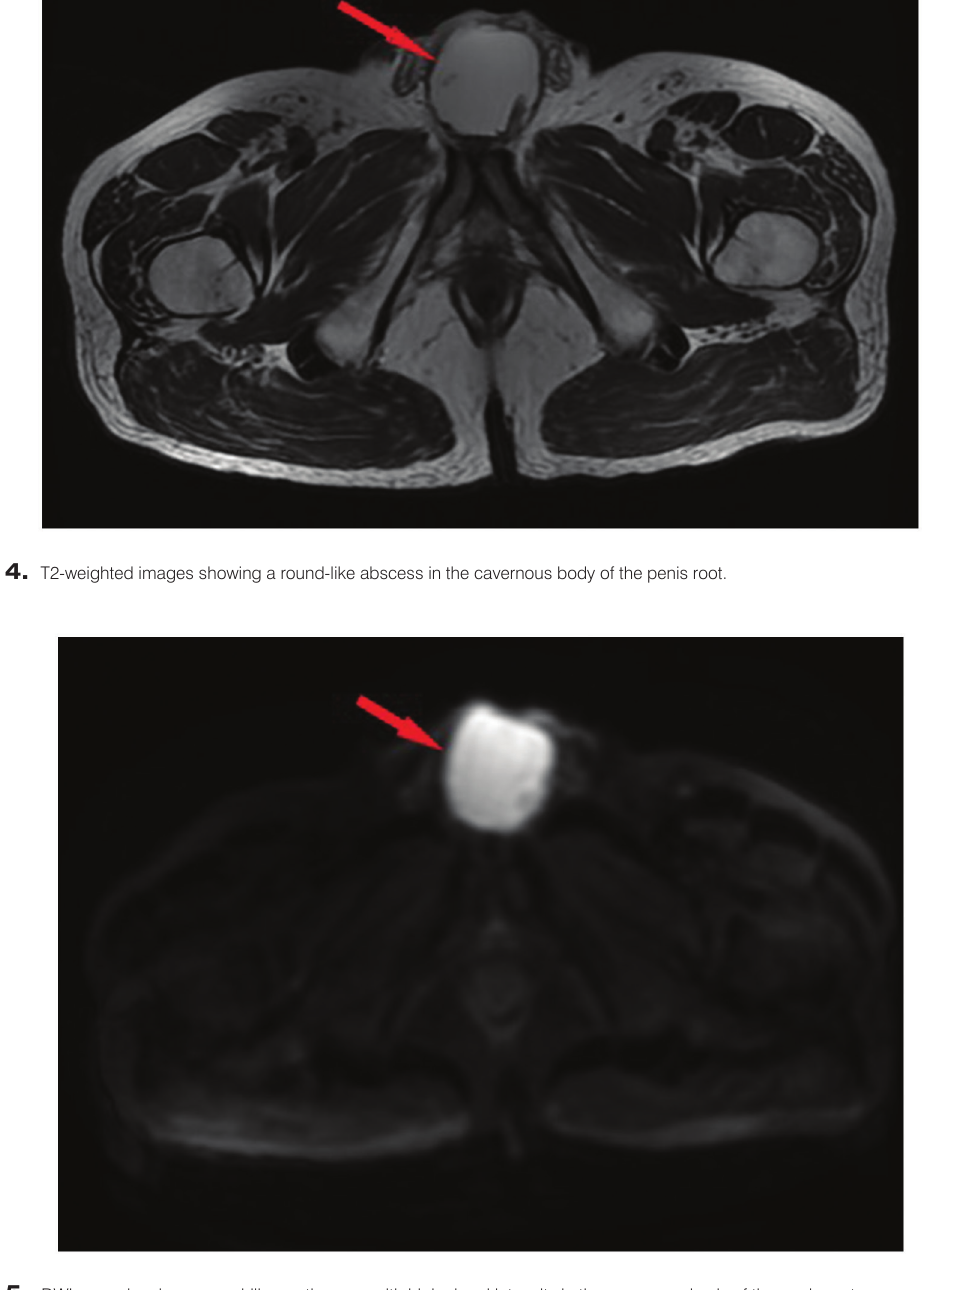
urine stream. Penile abscess often occurs in the cav- ernous body, its head, and subcutaneous fascia of the penis, and it is usually caused by a variety of pathogenic bacteria, including N. gonorrhoeae , E. coli , S. aureus